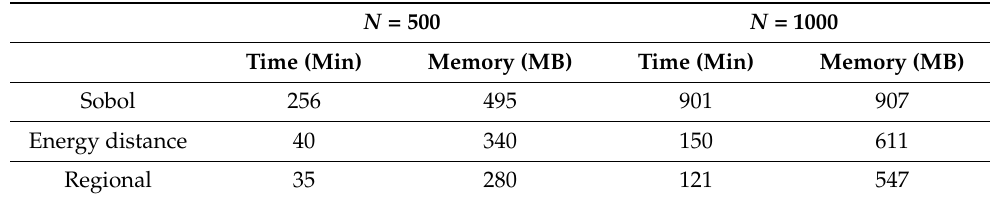
Table 2. Computation cost of the tested methods. N = 500 N = 1000 Time (Min) Time (Min)